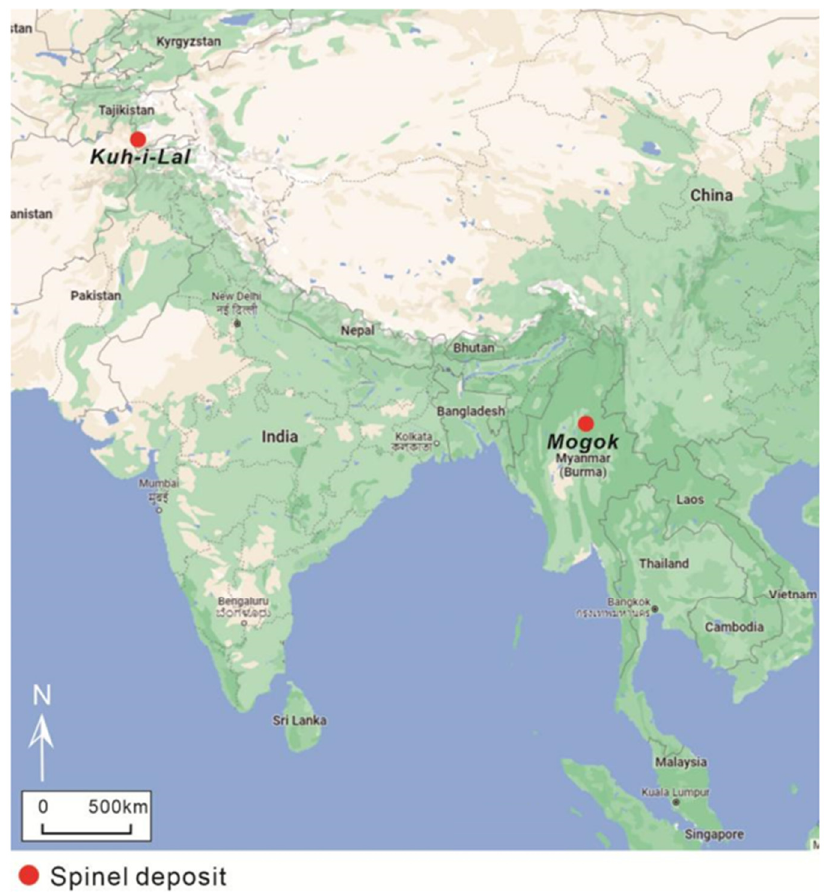
Figure 1. Map of spinel sources in Myanmar and Tajikistan (modified from Google Earth).